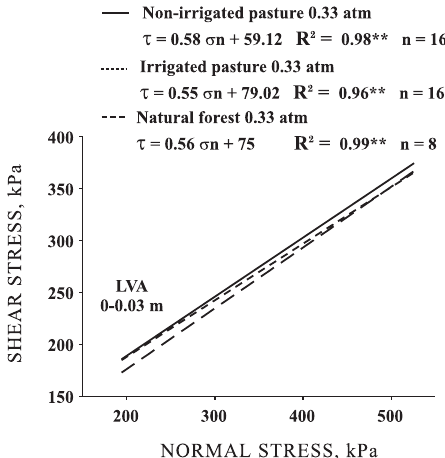
Figure 4. Rupture lines of an LVAd submitted to different managements, with samples equilibrated at a water tension of Table 5. Significance test according to Snedecor & Cochran (1989) between the rupture lines of a Red- Yellow Latosol with samples equilibrated at 33 kPa